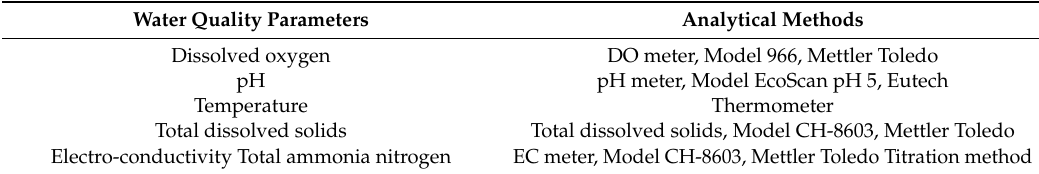
Table 1. Analytical methods used for measurements of water quality